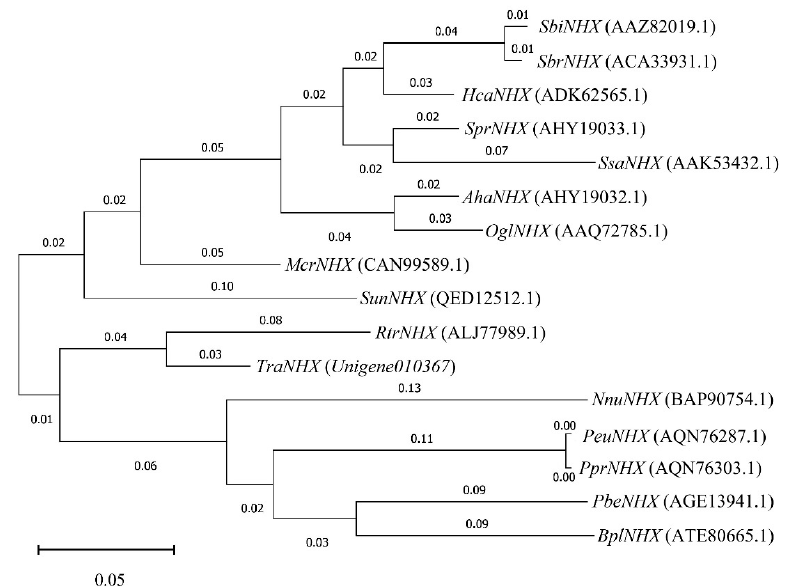
Figure 3. Phylogenetic tree analysis of T . ramosissima NHX and other species NHX. (Phylogenetic tree analysis of Unigene0103067 protein amino acid sequence and protein amino acid sequence of another 15 species of T. ramosissima ).